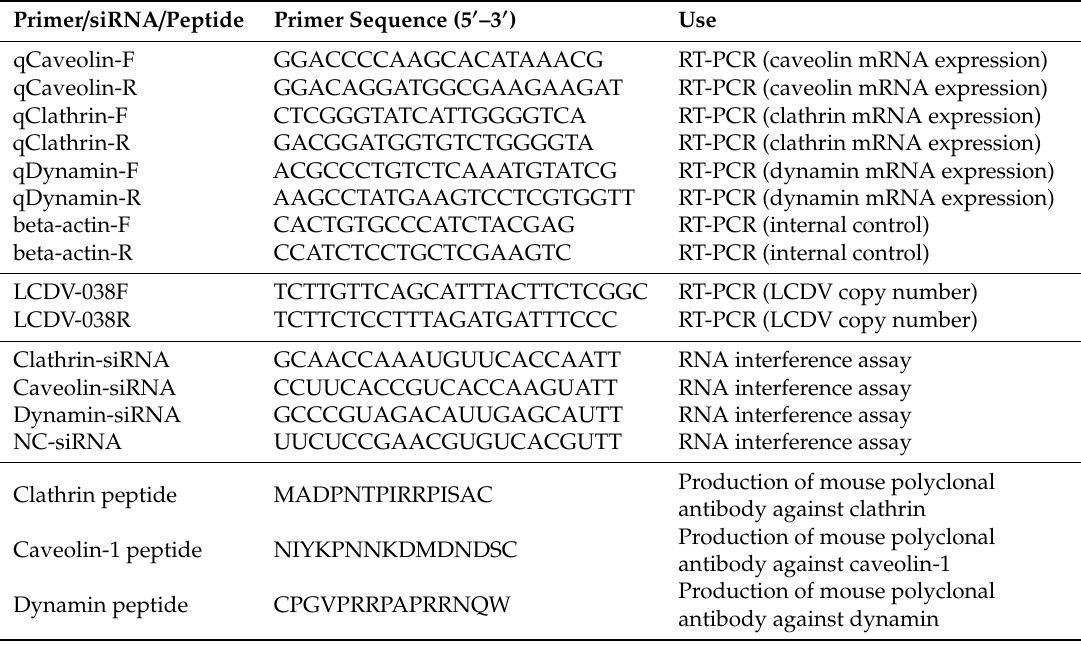
Table 1. Primers, siRNAs, and peptides used in this